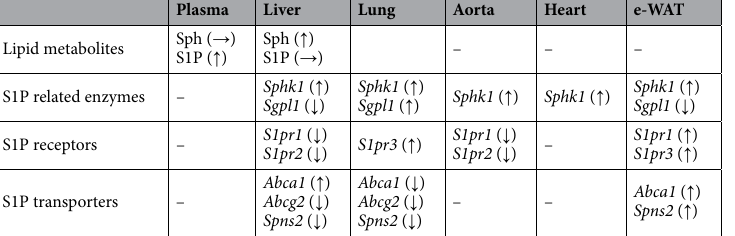
Table 1. Summary of altered S1P levels and its pathway related gene expressions (Sph: